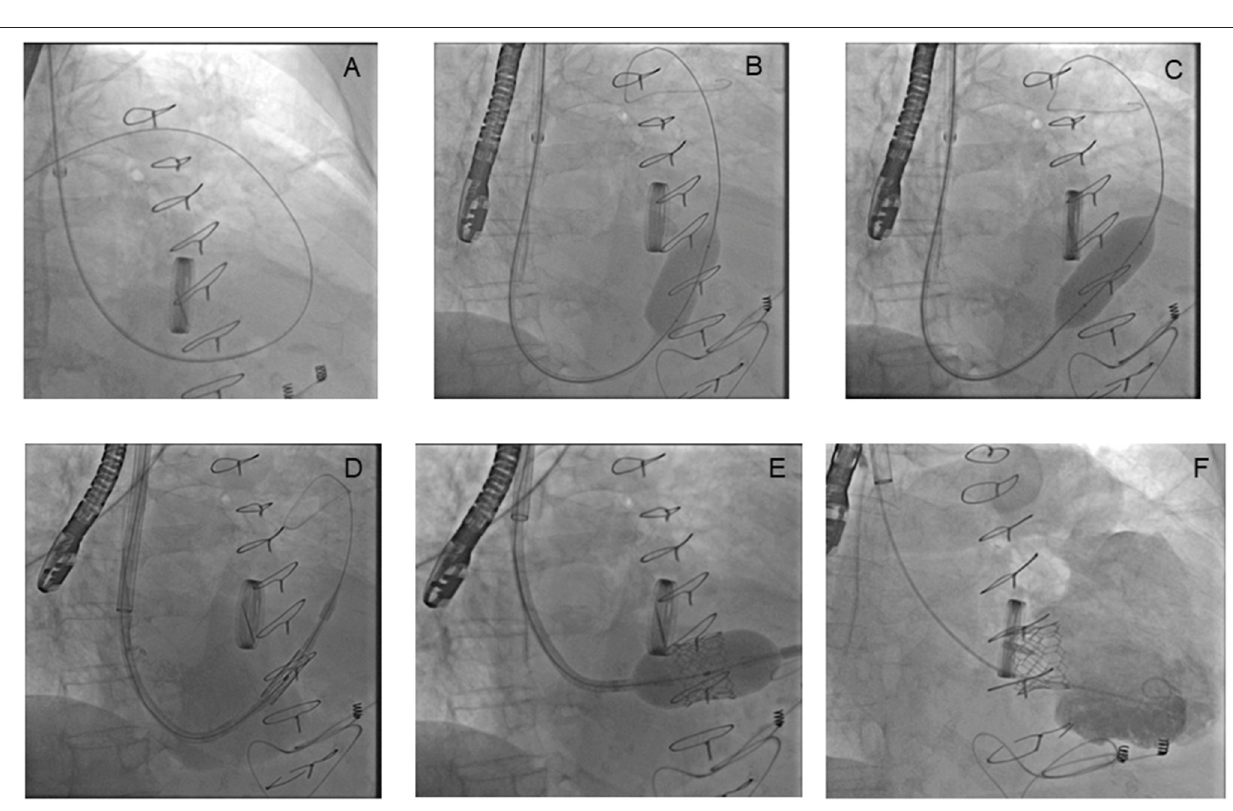
coaxiality with the tricuspid prosthesis). A left jugular vein was selected as an additional access (in order to monitor right side pressures and administer drugs) and transesophageal